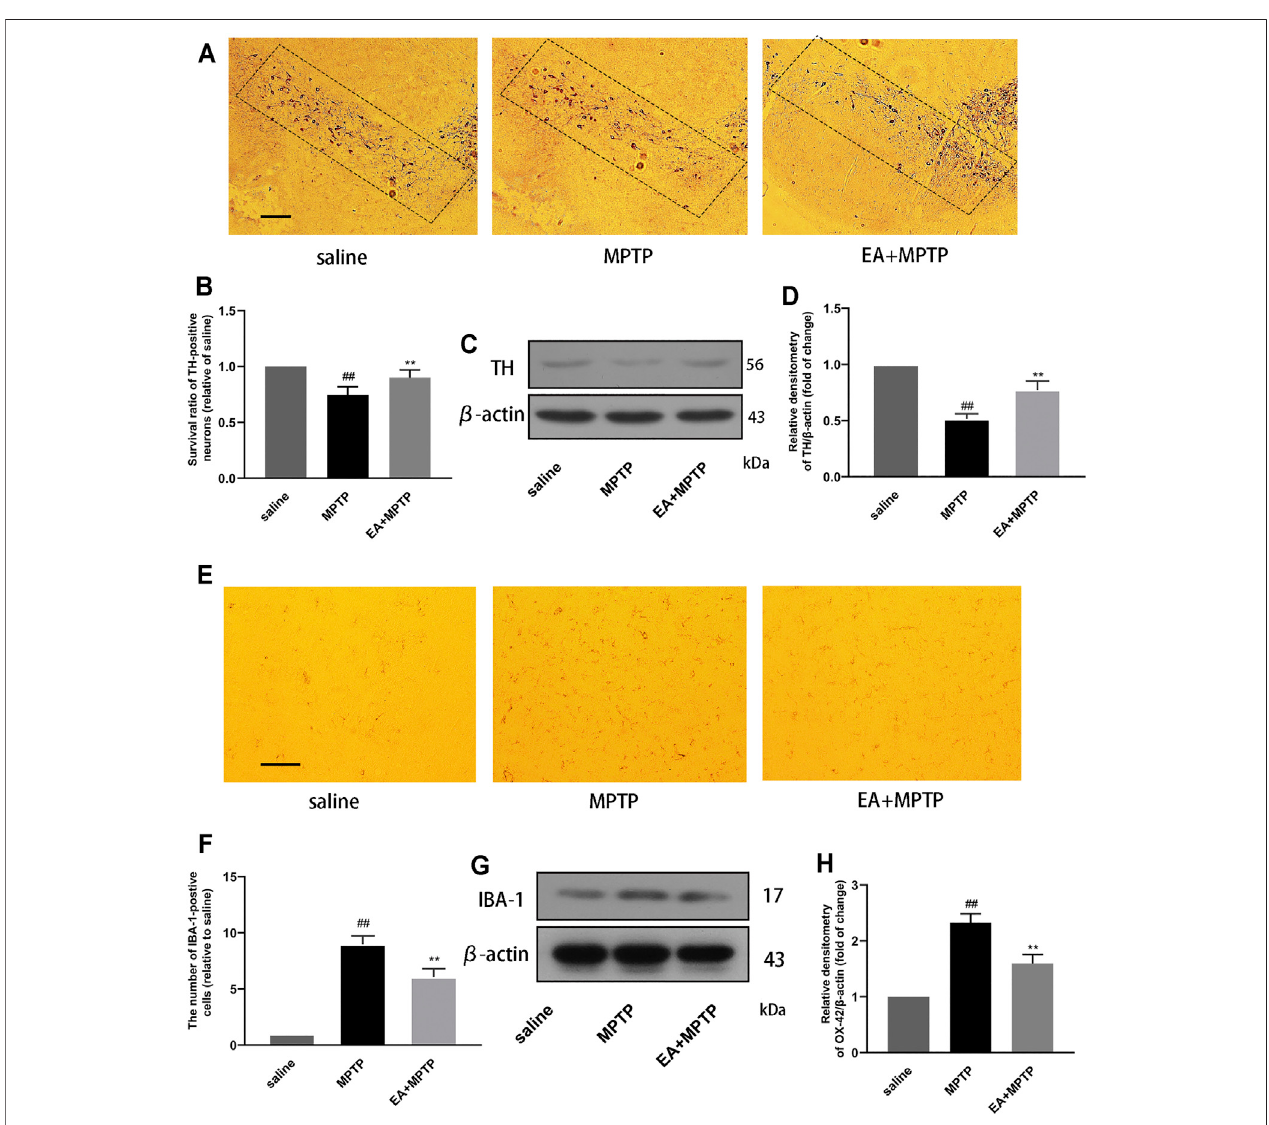
FIGURE7| EAreducesMPTP-inducedlossofdopaminergicneuronsandtheactivationofmicrogliainamousemodelofPD.Weobtainedmousemidbraintissue, formaldehyde fi xation, and paraf fi n section. The number of TH-positive cells was detected by immunohistochemical assay (100 μ m) (A,B) . The expression ofTH protein in the midbrain region of mice was detected by Western blot assay (C,D) . The number of IBA-1 – positive cells was detected by immunohistochemical assay (30 μ m) (E,F) . The expression of IBA-1 protein in the midbrain region of mice was detected by Western blot assay (G,H) . Results are represented as means ±